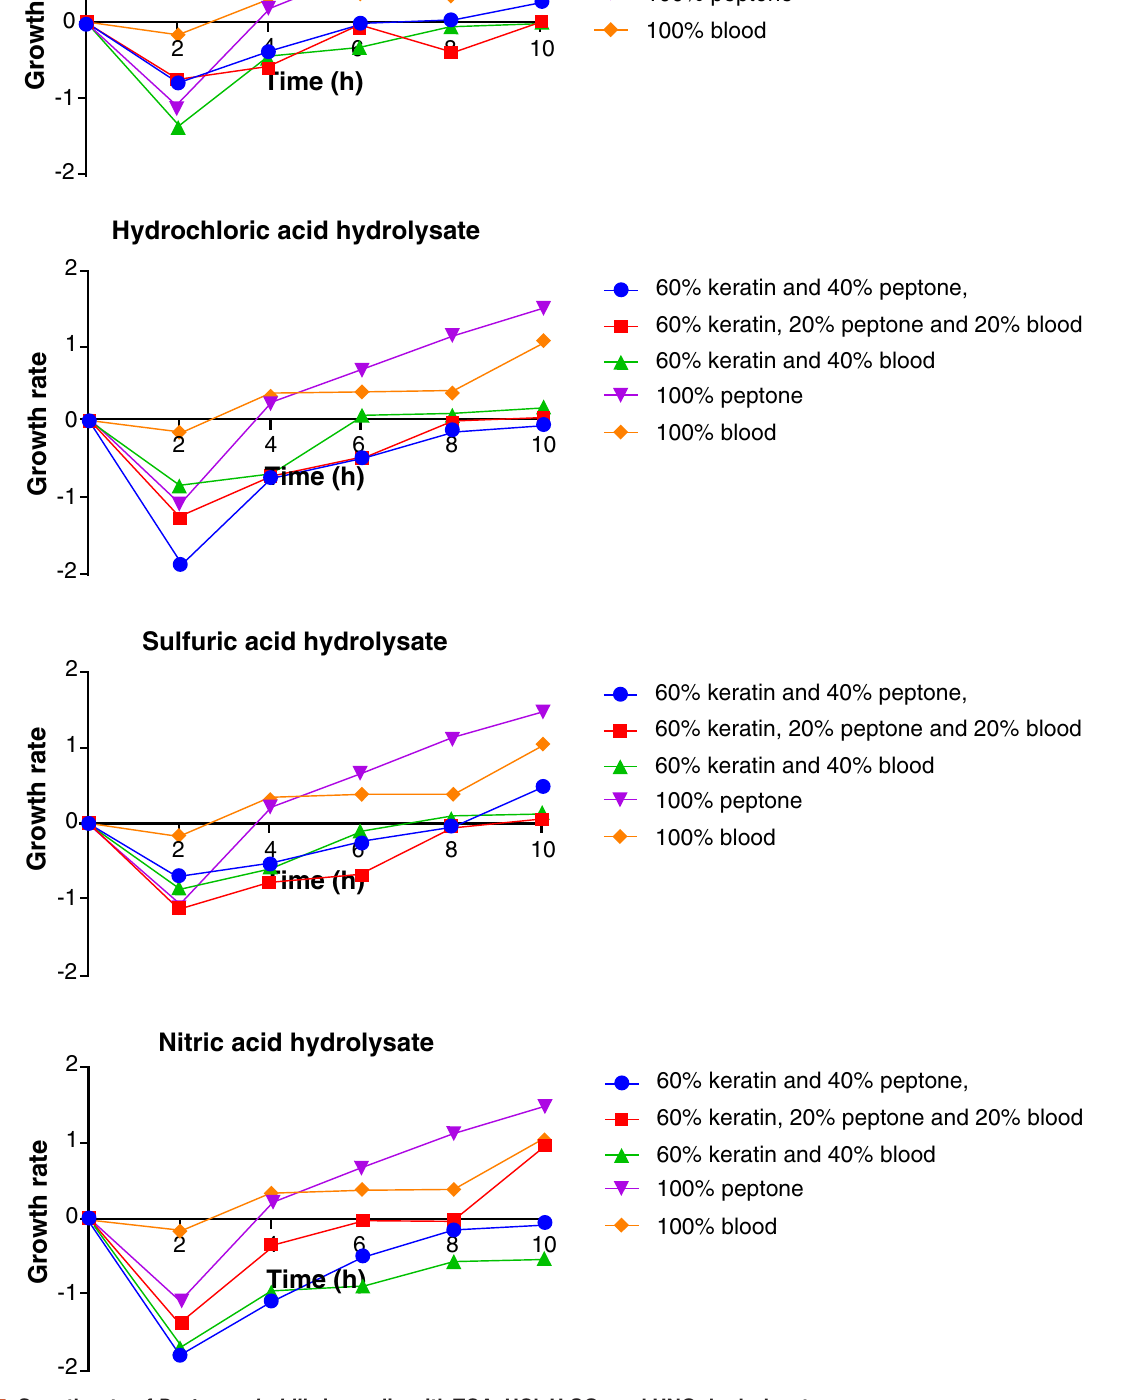
Figure 7. Growth rate of Proteus mirabilis in media with TCA, HCl, H